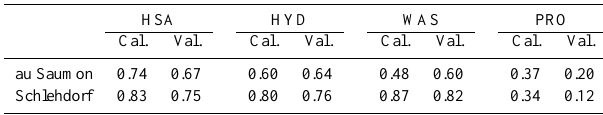
Table 2. Daily Nash-Sutcliffe efficiency coefficient (NS) for the